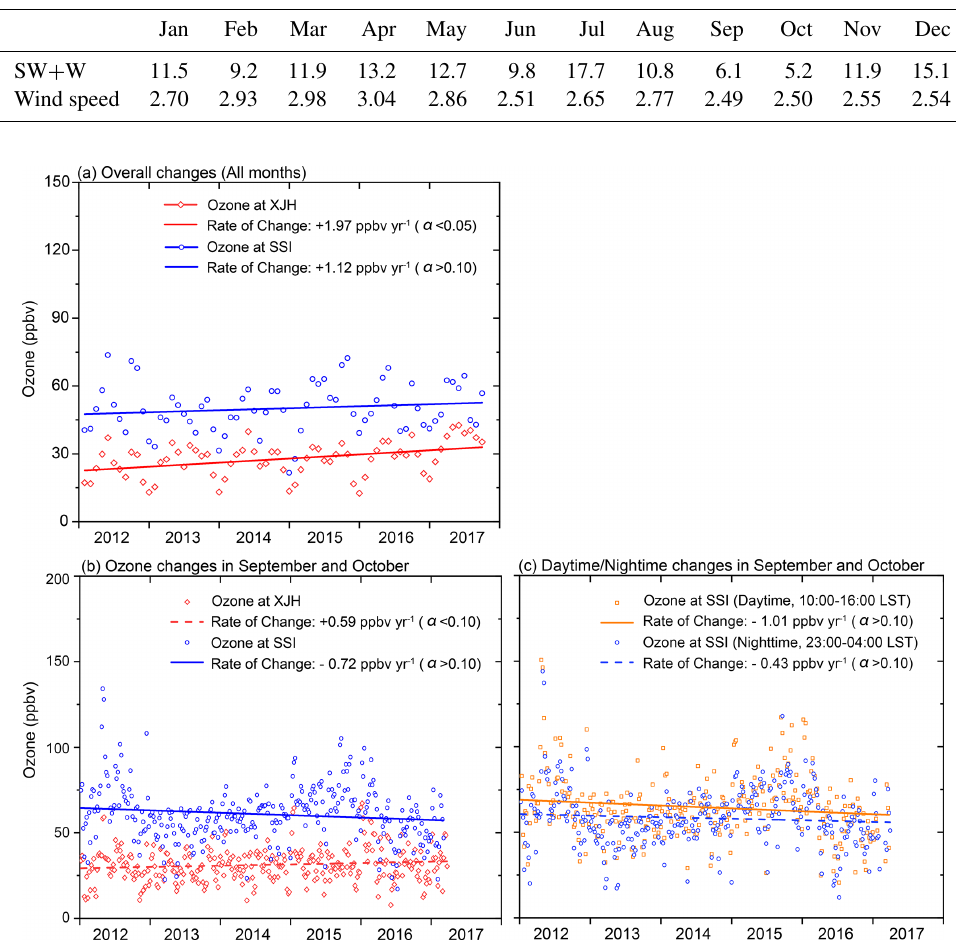
Figure 6. Variations of (a) monthly mean O 3 concentrations at the Sheshan Island (SSI, remote and oceanic) and Xujiahui (XJH, urban) sites during the period 2012–2017. (b) Corresponding variations of daily mean O 3 concentrations at SSI and XJH in September and October. (c) Variations of mean O 3 concentrations during daytime (10:00–16:00LST) and nighttime (23:00–04:00LST) at SSI.